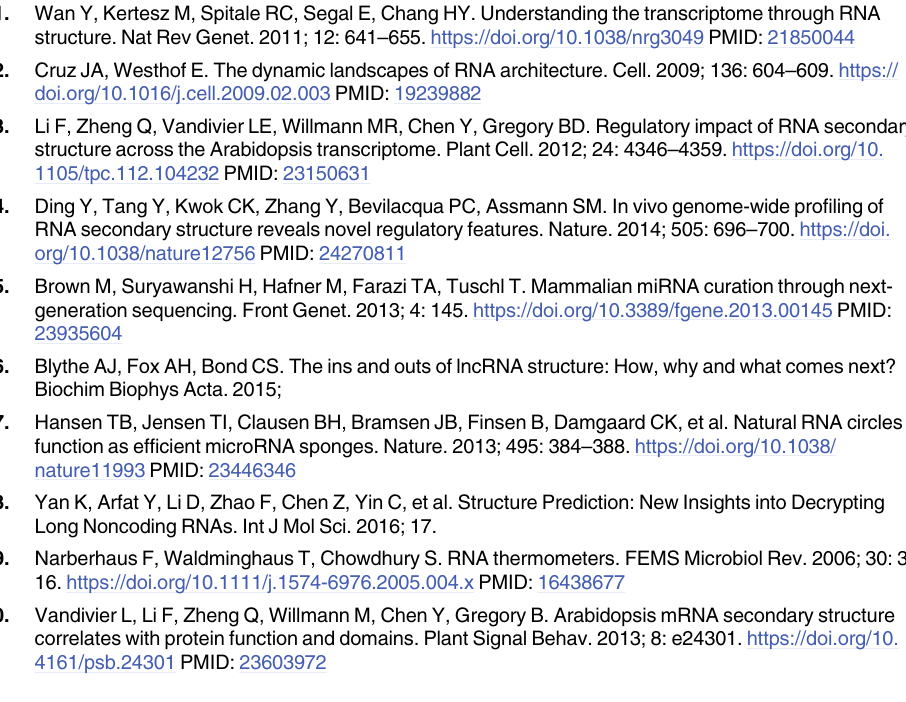
S2 Fig. Definition of RNA secondary structure dataset in JSON (SSDJ). S1 File. Methods for RNA secondary structure prediction with